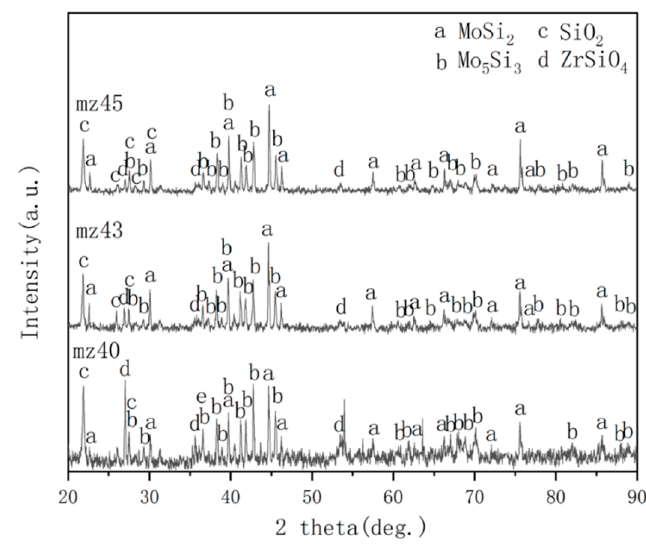
Figure 6. XRD patterns of MoSi 2 -ZrB 2 coatings after oxidation at 1250 °C for 60 h.